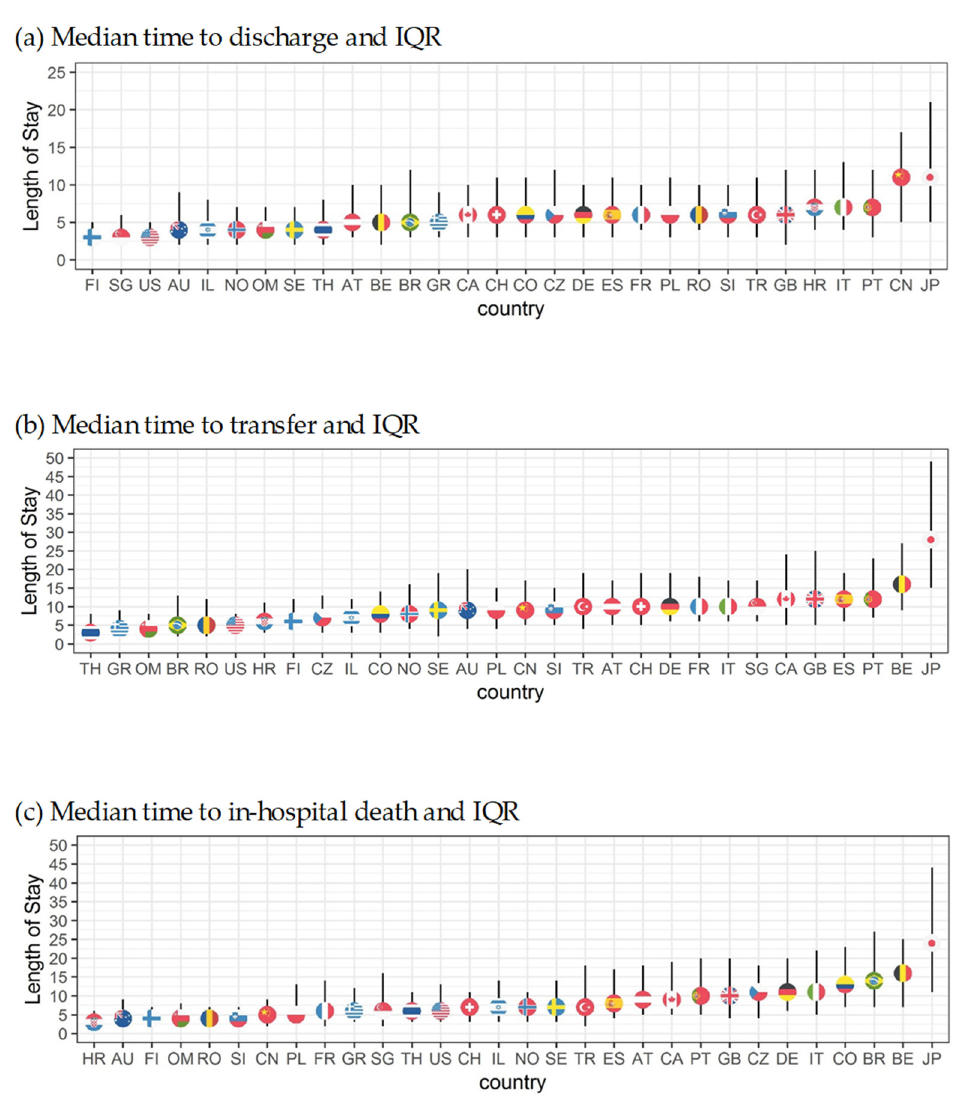
Figure 4. Median length of stay for all outcomes by country corrected for length bias.